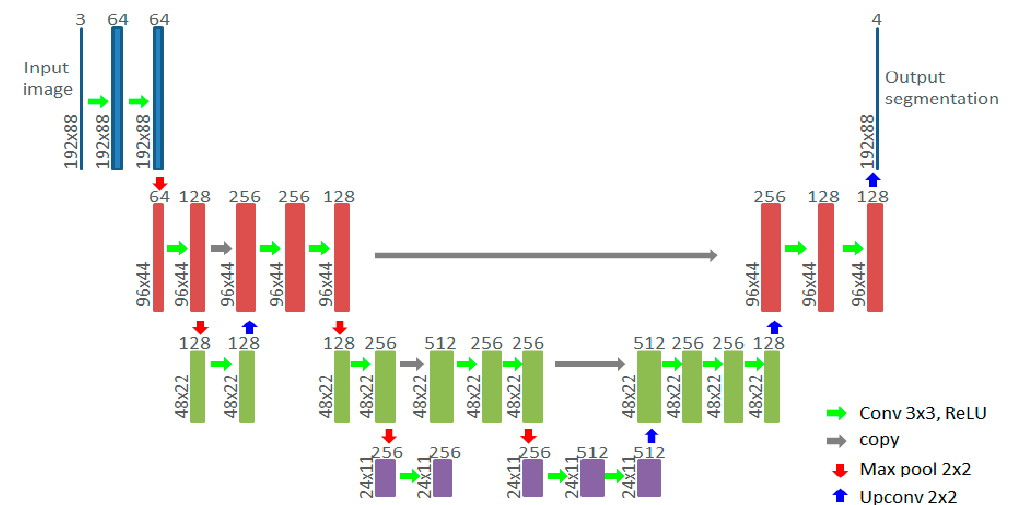
Figure 3. U-net architecture used for part segmentation. Each box corresponds to a multi-channel feature map. The number of channels is denoted on top of the box. The height and width are provided at the lower left edge of the box. The arrows denote the different operations.